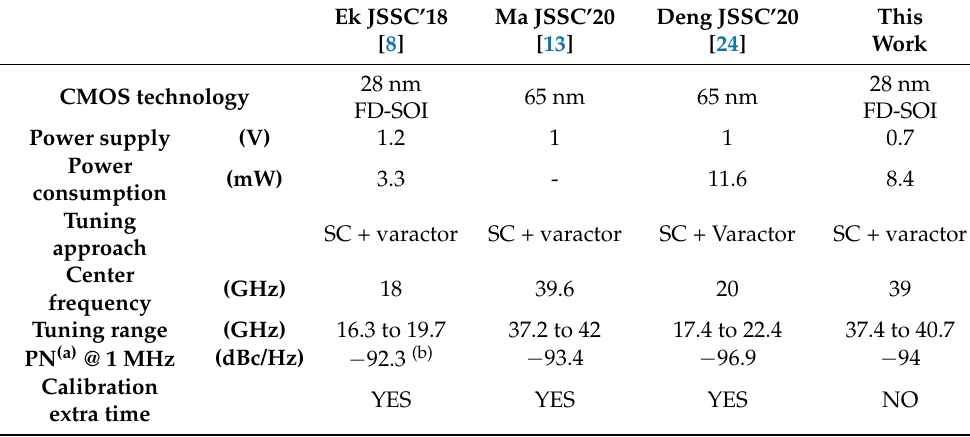
Table 1. Performance summary and comparison with the state of the